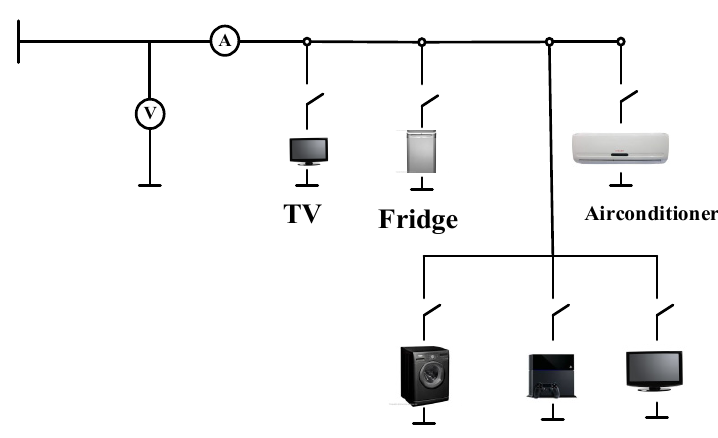
Figure 4. Single appliance configuration.